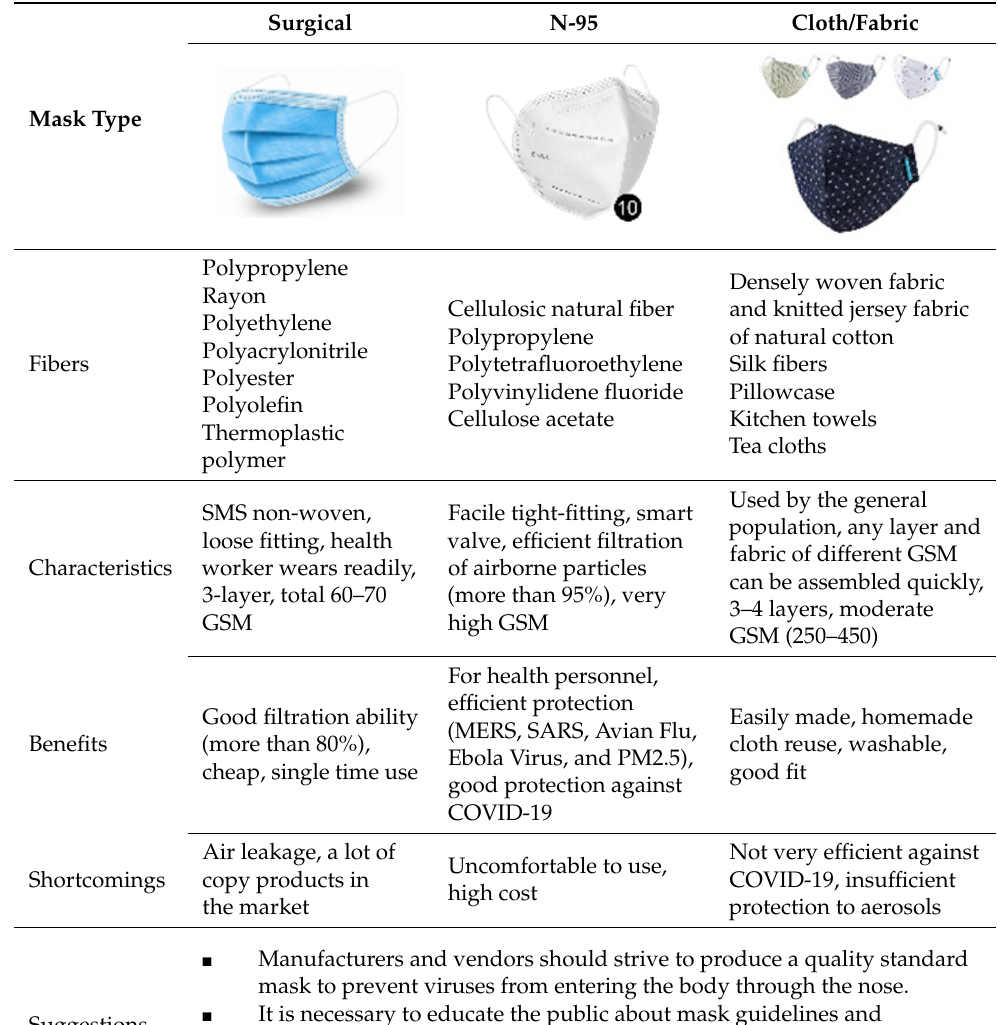
Table 5. General characteristics of different types of masks [119].